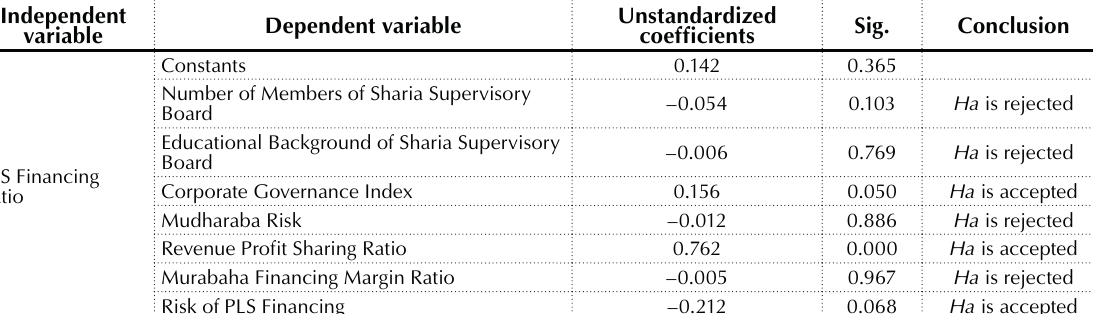
Table 3. Partial test result from Model 1